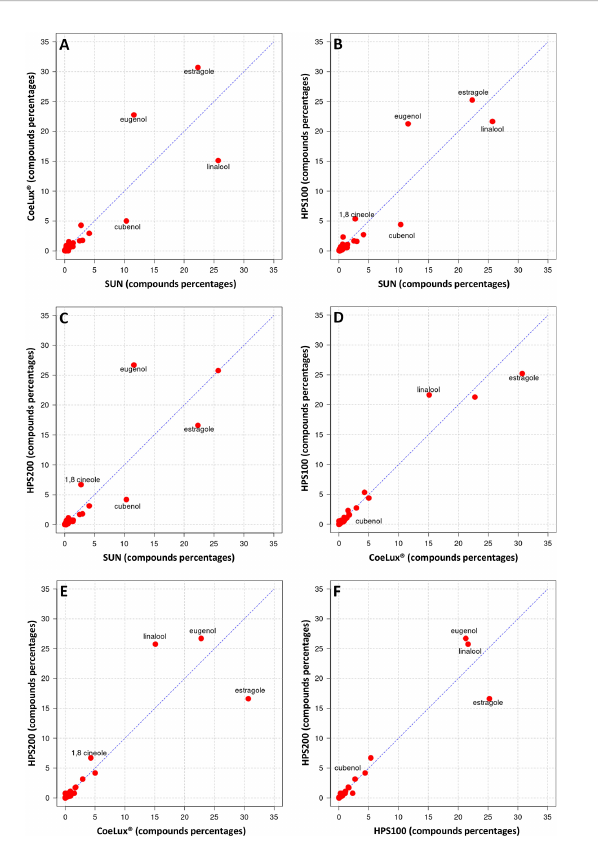
FIGURE 8 Cross-plot comparison of the biochemical composition in the essential oil of M. piperita plants grown under different light treatments. Respectively, (A) CoeLux® vs SUN, (B) HPS100 vs SUN, (C) HPS200 vs SUN, (D) HPS100 vs CoeLux®, (E) HPS200 vs CoeLux®, and (F) HPS200 vs HPS100. Points away from the bisector represent molecules differentially expressed in the two light treatments under analysis, while points on the bisector represent molecules present in the same percentage in both samples.